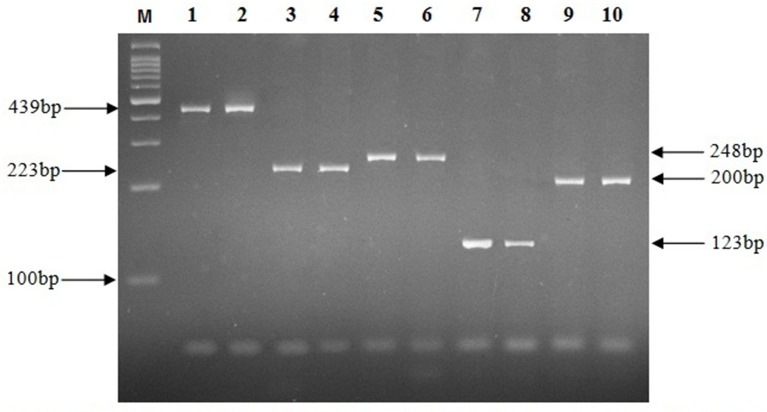
Electrophoresis of PCR products on a 2% agarose gel. M, Molecular size marker; Lanes 1, 2, 439 bp fragment of hsp65 gene; Lanes 3, 4, 223 bp fragment of mtp40 gene; Lanes 5, 6, 248 bp fragment of IS1081 gene; Lanes 7, 8, 123 bp fragment of IS6110 gene; Lanes 9, 10, 200 bp fragment of mpb64 gene.